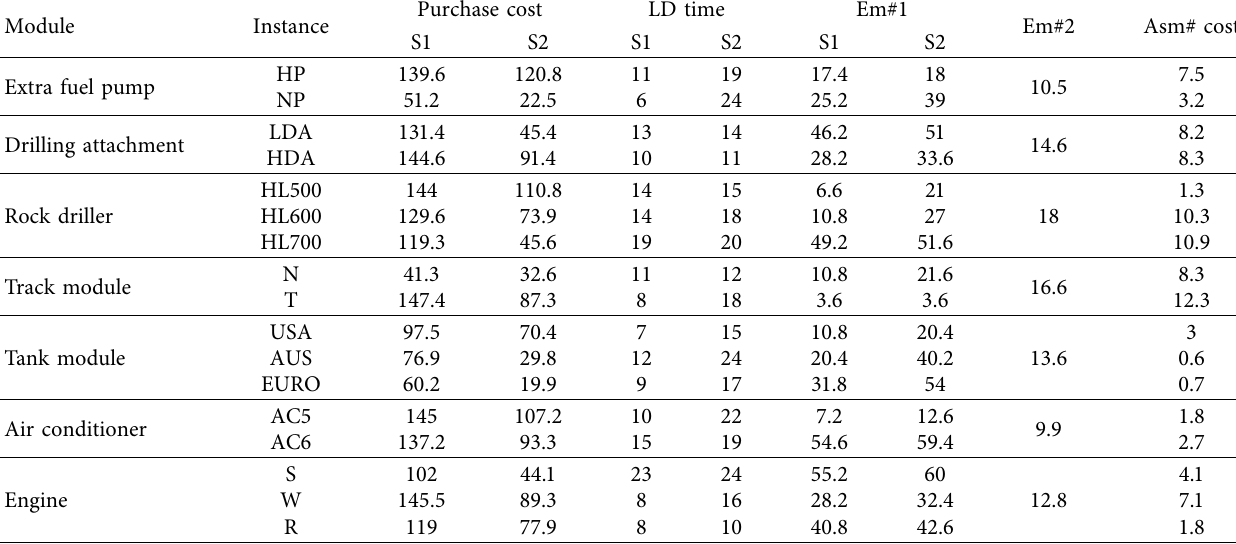
Table 4: Configuration data about module